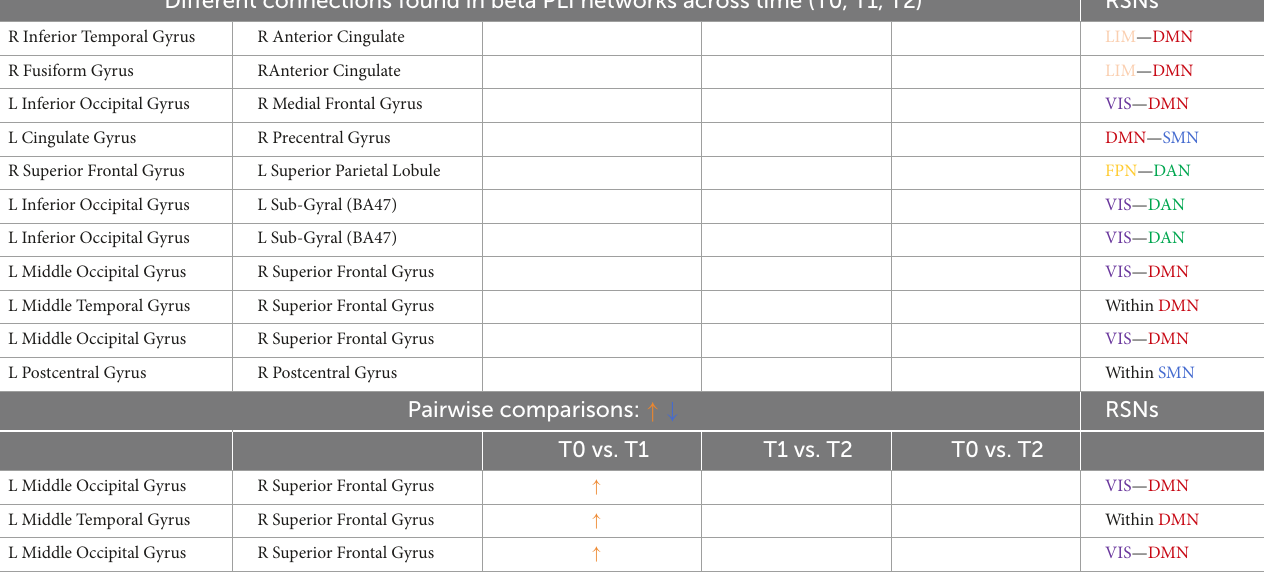
TABLE 4 Different connections found in beta PLI networks across time (T0, T1, T2) and after pairwise comparisons (L denotes left hemisphere; R denotes right hemisphere). Different connections found in beta PLI networks across time (T0, T1,